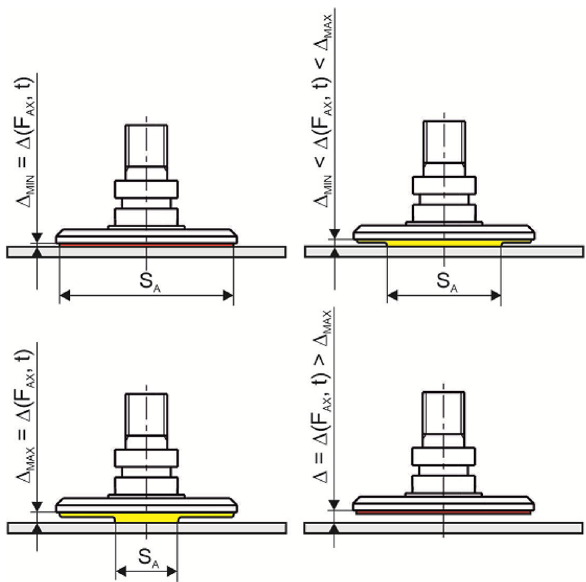
Fig. 15 Presumed mechanism for tearing off the adhesive layer